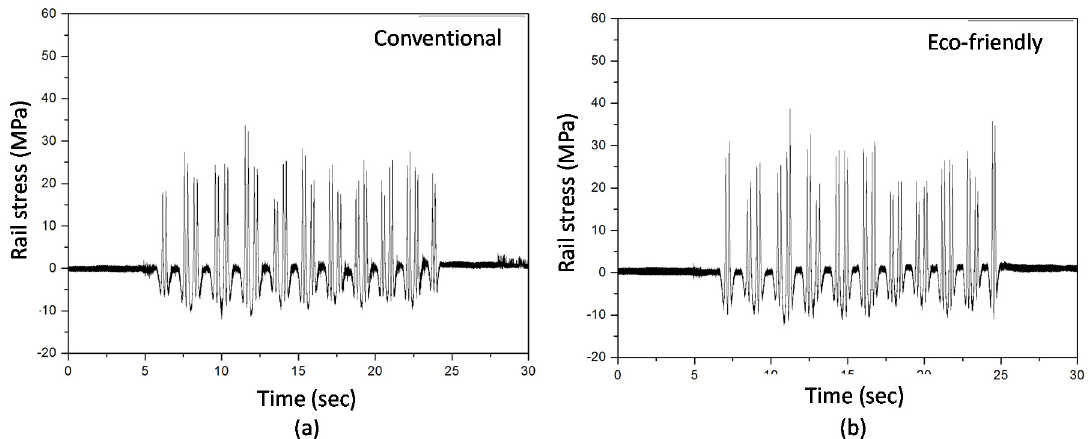
Figure 15. Time history of the stress on the bottom surface of rail: ( a ) conventional B2S and ( b ) eco-friendly B2S.